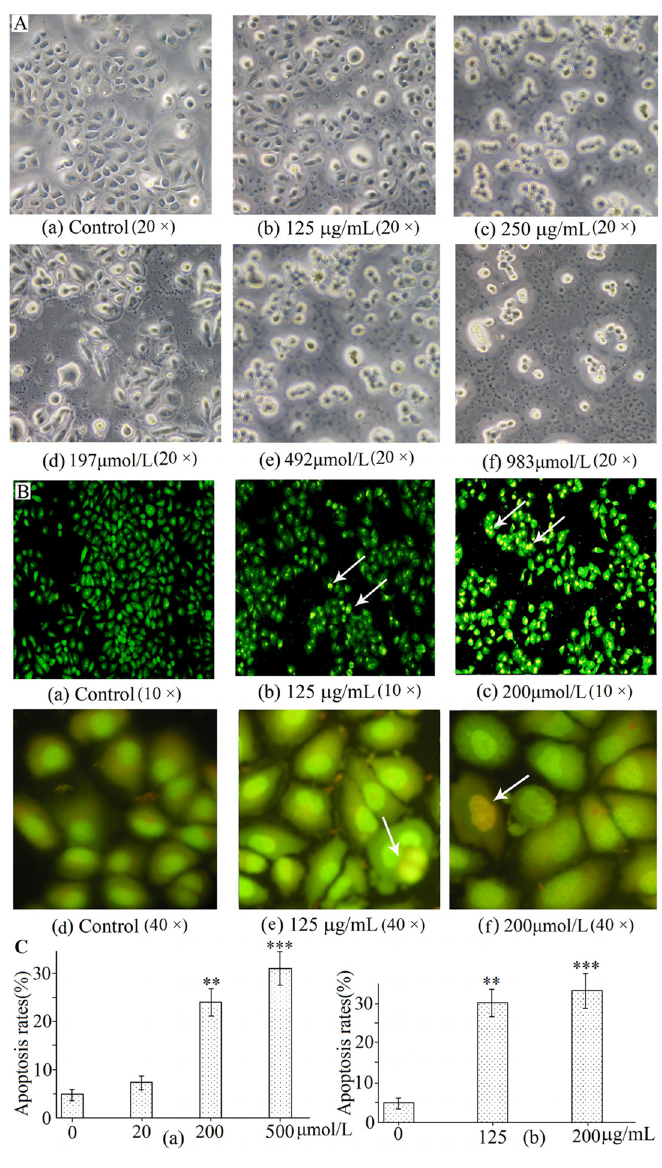
Fig 2. The Morphology Changes and apoptosis rates of H-EtOAc fraction and DMQ treated HepG2 cells. A(a)-(c). The morphology changes of HepG2 cells treated with gradient H-EtOAc fraction for 24 h using a visible light under light microscope for 24 h. A (d)-(f). The morphology changes of HepG2 cells treated with DMQ for 24 h. A visible light was used under light microscope (20 × magnification). B(a)-(c). Morphological observation of fluorescence microscope (10 × magnification) for 24 h. B(d)-(f). Morphological observation of fluorescence microscope (40 × magnification) for 24 h. A green excitation wavelength (460 — 495nm) and emission wavelength 510nm filter was used by staining with AO/EB. C(a). Apoptosis was measured on HepG2 cells treated with gradient DMQ for 24 h. C(b). Apoptosis was measured on HepG2 cells treated with H-EtOAc fraction for 24 h. Values are means ± SD of three independent experiments. * ( p < 0.05), ** ( p < 0.01) and *** ( p < 0.001) represented significant differences compared to the